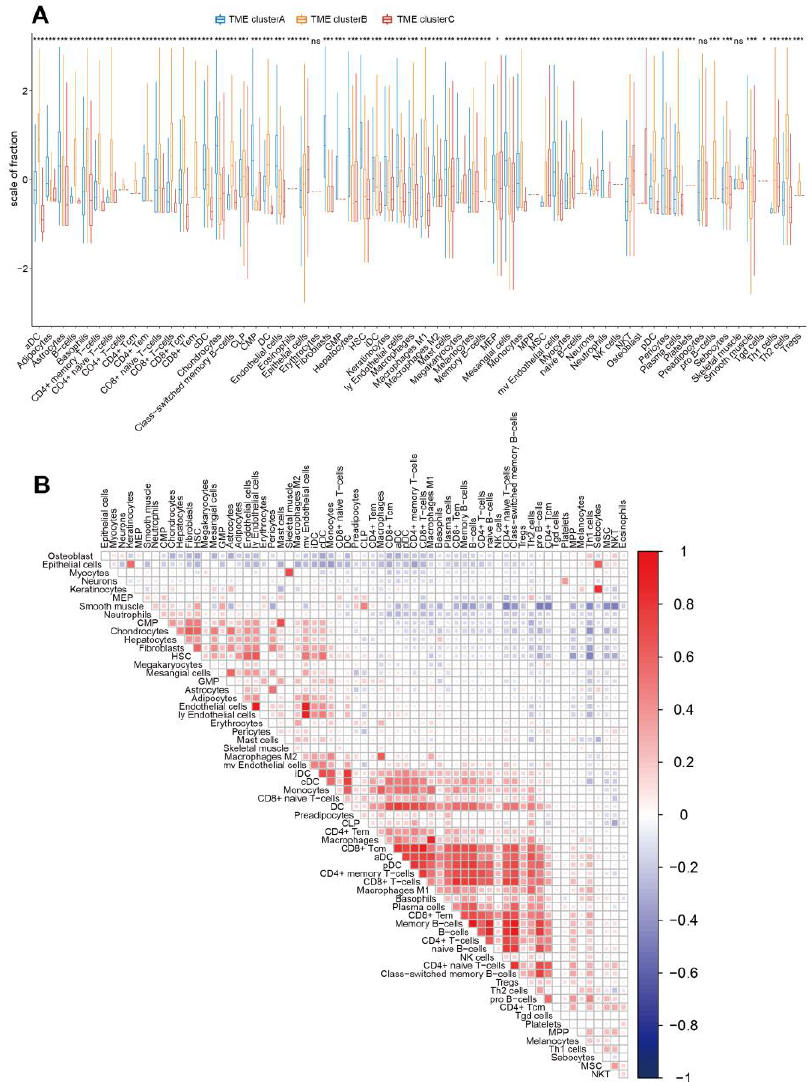
Figure 3. ( A ) The fraction of tumor-infiltrating cells in three TME subtypes. The statistical differ- ence between the three TME subtypes was compared through the Kruskal–Wallis test. * p < 0.05; *** p < 0.001; ns no significance. ( B ) Cellular interaction of the TME